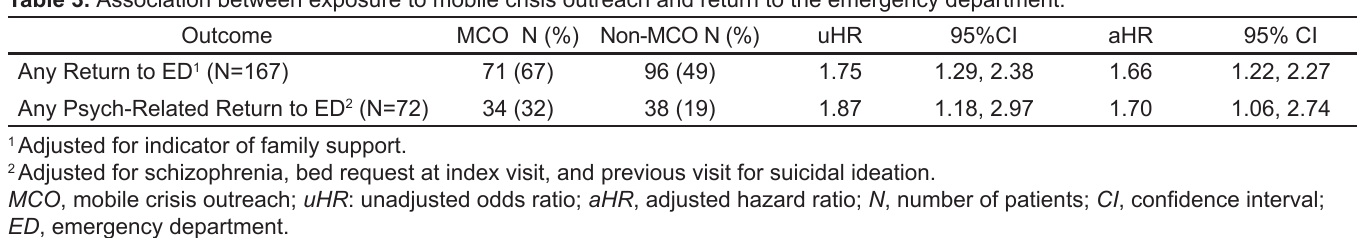
Table 3. Association between exposure to mobile crisis outreach and return to the emergency department.